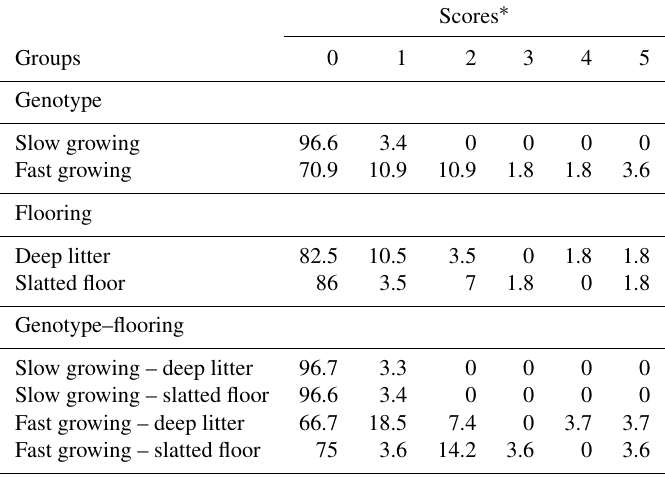
Table 4. Prevalence of gait scores in the groups in week 8 (%).